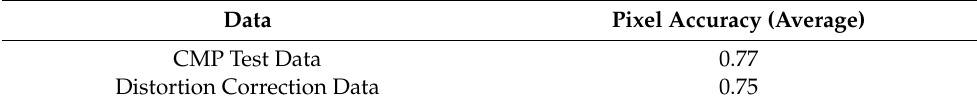
Table 15. Pixel accuracy of CMP test and distortion correction data.